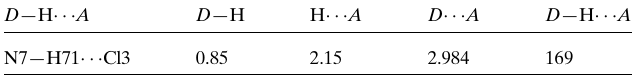
Table 1 Hydrogen-bond geometry (A˚ , (cid:2) ).